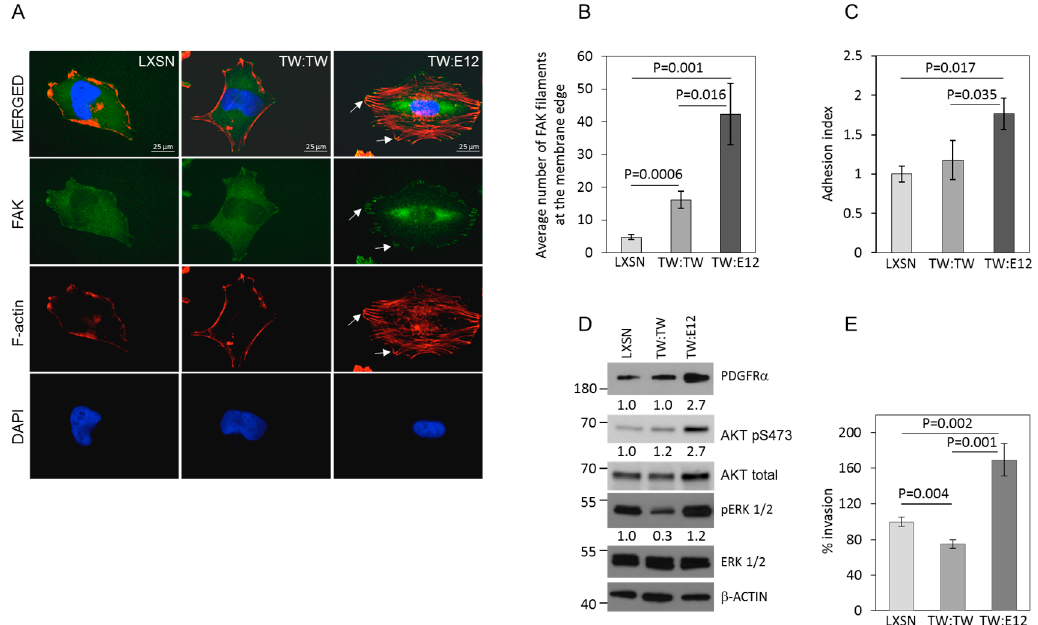
Figure 4. Differential regulation of cellular phenotypes by expression of TW:E12 and TW:TW forced dimer constructs (FDCs). ( A ) Representative confocal images of FAK immunocytochemistry and phalloidin staining to detect F-actin in T98G cells expressing LXSN control vector, TW:TW and TW:E12 FDCs. FAK localized at membrane (arrows) appears to be increased in TW:E12-expressing cells and co-localize with F-actin filaments. ( B ) Quantification of FAK at the membrane edge. P values are shown. ( C ) Cells expressing TW:E12 FDC show increased adhesion to Fibronectin 1 compared to TW:TW FDC or vector control T98G cells. Data shown as fold change over mean adhesion in control accepted as 1. P -values are shown. ( D ) Dimer dependent activation of pro-invasive proteins. Overexpression of TW:E12 heterodimer results in activation of PDGFRa protein expression and pAKT S473 phosphorylation. Overexpression of TW:TW homodimers results in inhibition of ERK1 / 2 phosphorylation. Relative expression normalized by actin is shown under the corresponding panel. Expression in cells transduced with empty vector accepted as 1. ( E ) Matrigel invasion assay showing TW:E12 heterodimer FDC expression markedly increases invasion while TW:TW homodimer FDC expression slightly decreases invasion compared with vector controls in T98G cells.